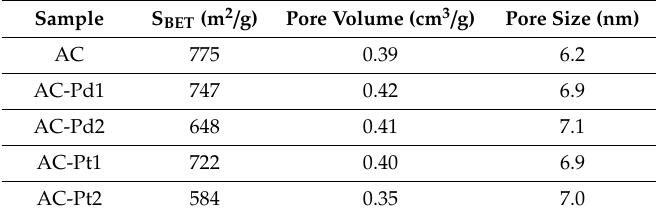
Table 3. Brunauer—Emmett—Teller Surface Area Analysis (BET) characterization of Pd / AC and Pt / AC